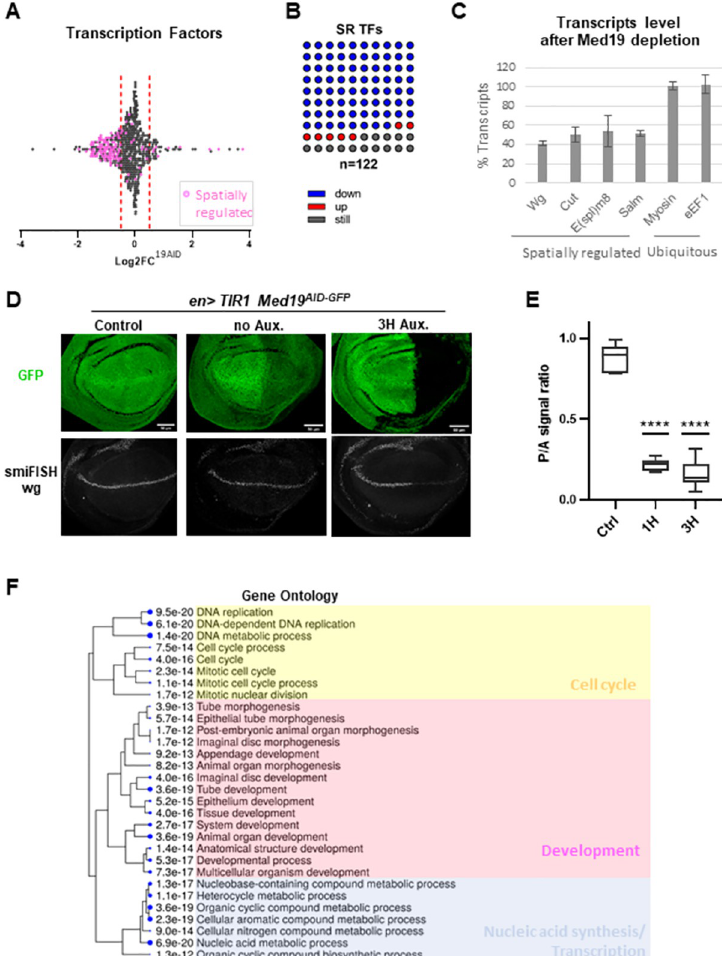
Fig 4. Med19 promotes the expression of the spatially regulated developmental genes. (A) Scatter plot depicting the distribution of the Log2FC values of the 573 transcription factors found significantly expressed in the wing imaginal disc from the RNAseq data. The transcription factors with a demonstrated spatial transcriptional regulation (SR TFs) in the wing imaginal disc are shown in purple (n = 122). (B) Dot plot 10x10 showing the proportion of the non- regulated (dark grey), upregulated (red), or downregulated (blue) genes among the 122 SR transcription factors. (C) Bar graph made from RT-qPCR data showing the relative level of transcripts of 6 genes known to be spatially regulated (wg, cut, E(Spl)m8, sal or ubiquitous (Myosin, E2F1) in the wing discs of ub > ; Med19 AID-GFP larvae after Med19 AID depletion was carried out for 4 hours in all the disc cells (percentage of the control in which Med19 AID degradation was not triggered). The graph shows the mean and standard deviation of 3 independent experiments. (D) Confocal images of the wing pouch region of dissected en > ; Med19 AID wing discs that were subjected to Med19AID degradation (en > 3H Aux), or not (control: No Gal4 driver, and en > no Aux), and in which wingless (wg) pre-mRNA were visualized by smiFISH using intronic probes and Med19 degradation by direct GFP fluorescence. top images:Med19 AID GFP signal. bottom images: wg smiFISH signal. (E) Wing disc D/V boundary posterior to anterior wg smiFISH signal ratio established in en > ; Med19 AID wing discs: No auxin control (no Aux. n = 5), 1H auxin (n = 6), and 3H auxin (n = 6). ���� : P value < 0.0001 (Unpaired t test). (F) Hierarchical clustering tree of the 30 best FDR of the GO terms associated with the downregulated genes. The size of the solid circles is proportional to the enrichment False Discovery Rate (FDR). GO clusters appear related to development (purple), nucleic acid synthesis (blue), and cell cycle regulation (yellow). to the general behavior in which an equal distribution between down and up regulation is seen (Fig 2B), the vast majority (91%) of the SR TFs deregulated upon Med19 AID loss fall in the group of the downregulated. We experimentally validated this finding by measuring using RT- qPCR the transcripts level of three developmental TFs (encoding by cut , salm and E(spl)m8 ) in